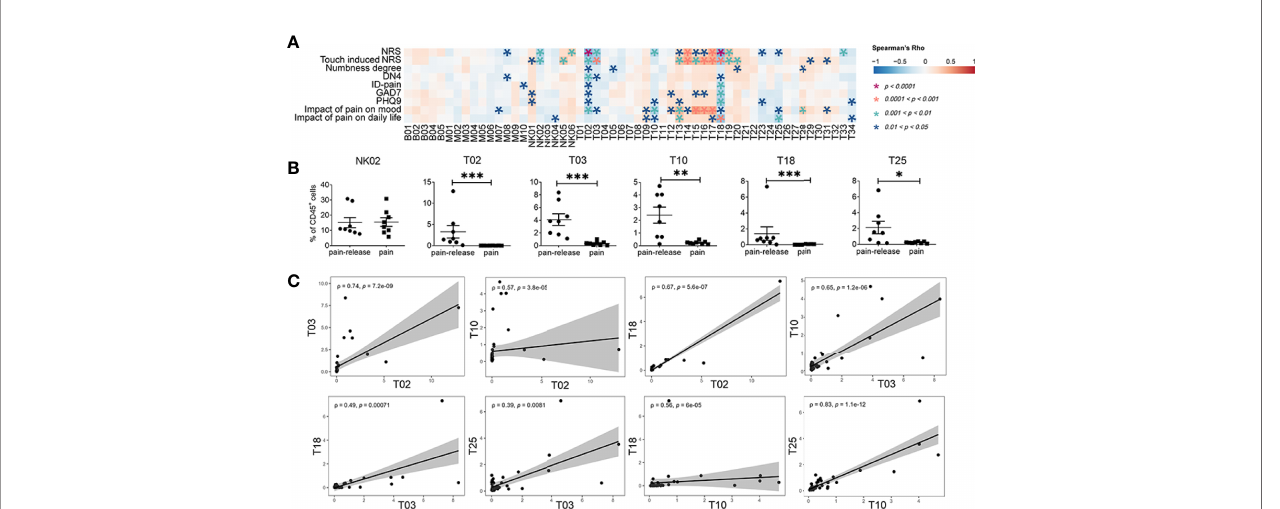
FIGURE 3 | Correlations between immune subsets and clinical pain related scores. (A) Spearman ’ s correlation analysis showing the correlations between each immune cluster and clinical pain-related scores. (B) The difference in the frequency of different immune subsets with slow response patterns that negatively correlated with clinical pain-related scores ( Figure 2E ) in the pain or the pain-release groups at the T 4 time point . (C) The correlation analysis between each immune subset with slow response patterns. *P < 0.05, **P < 0.01, ***P <